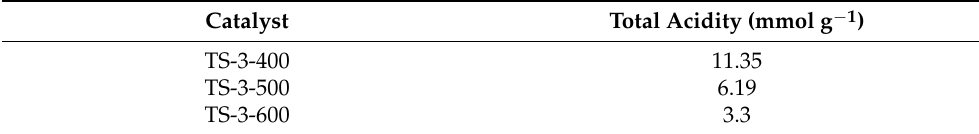
Table 2. Acidity test of TS-3 at 400, 500, and 600 ◦ C.